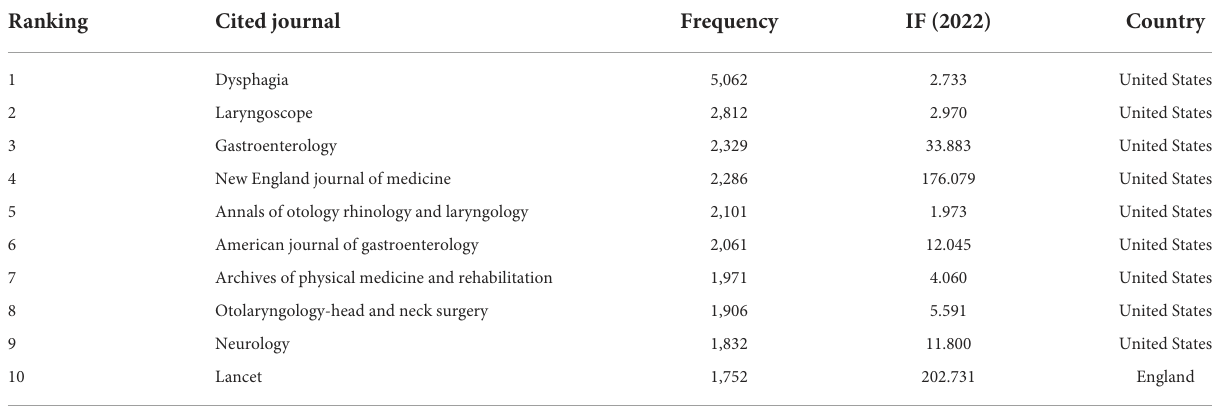
TABLE 5 The top ten cited journals and its influencing factors (IFs) in the research field of dysphagia from 2012 to 2022.